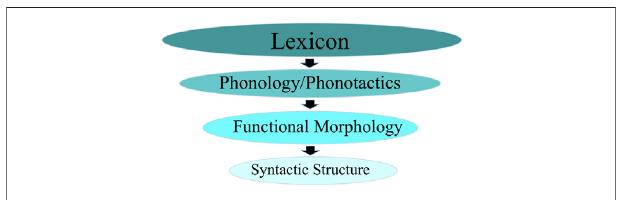
FIGURE 1 | | Implicational hierarchy of input cues Adapted from (Rothman et al., 2013; Rothman et al.,